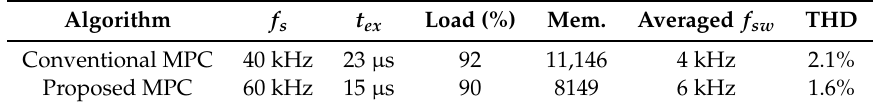
Table 4. Comparative